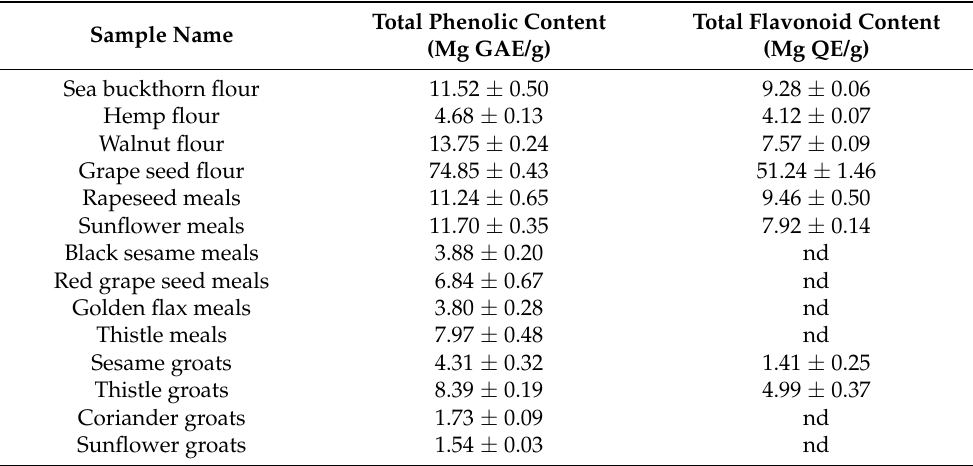
Table 1. Phenolic content and flavonoid content in the byproducts of the vegetable oil